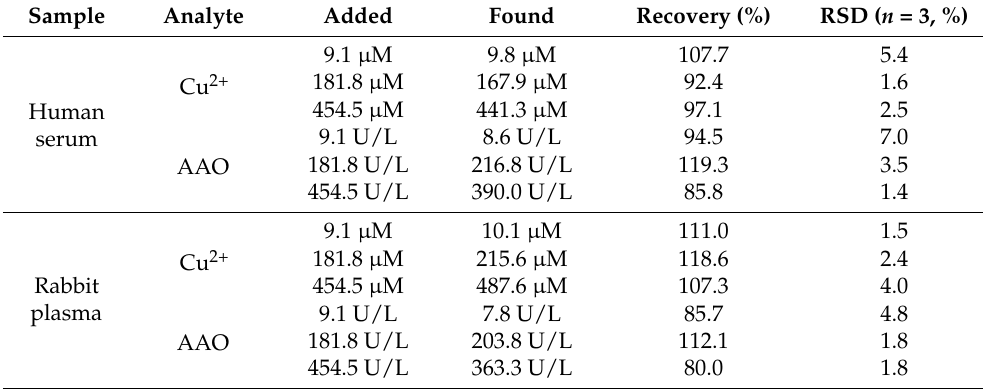
Table 4. Determination of Cu 2+ and AAO in human serum and rabbit plasma based on the ALP-like activity of